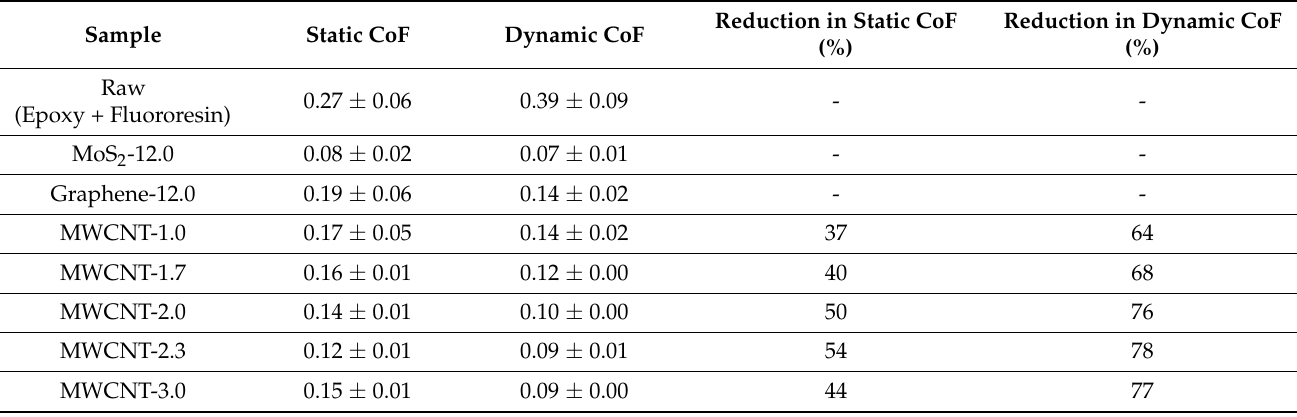
Table 8. CoFs of solid lubricants with different MoS 2 and MWCNT contents.